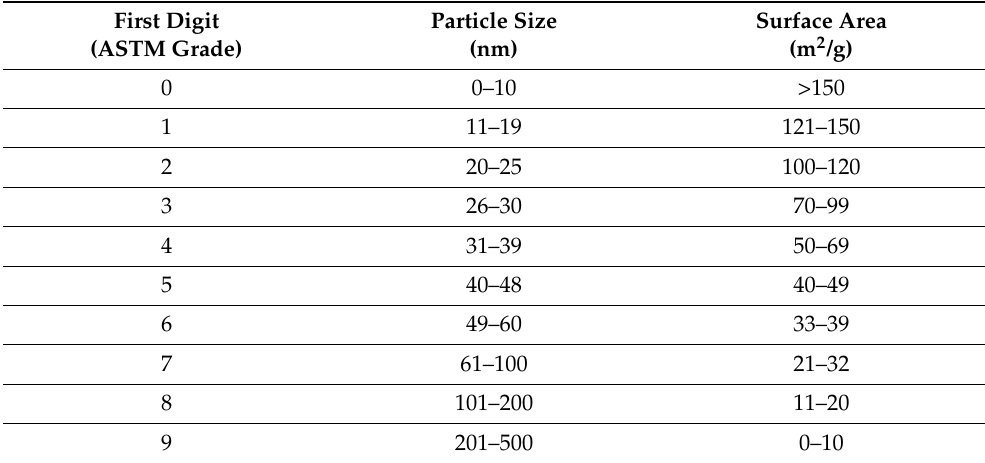
Table 2. ASTM nomenclature for CB grades [56].